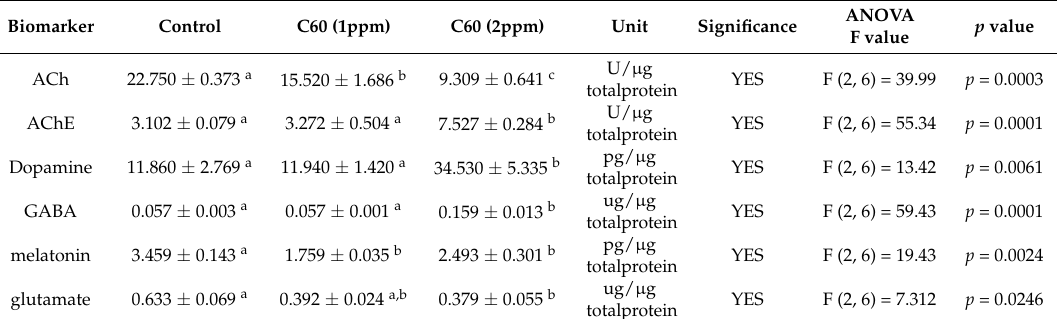
Table 2. Detection of biochemical parameters in the brain tissue for C 60 NPs-exposed zebrafish after 12-day